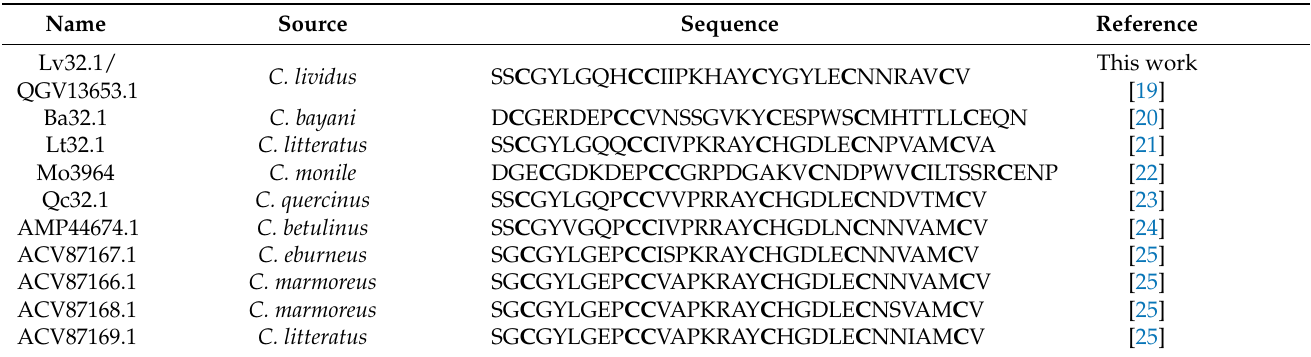
Table 1. Reported conotoxins or precursors with cysteine framework